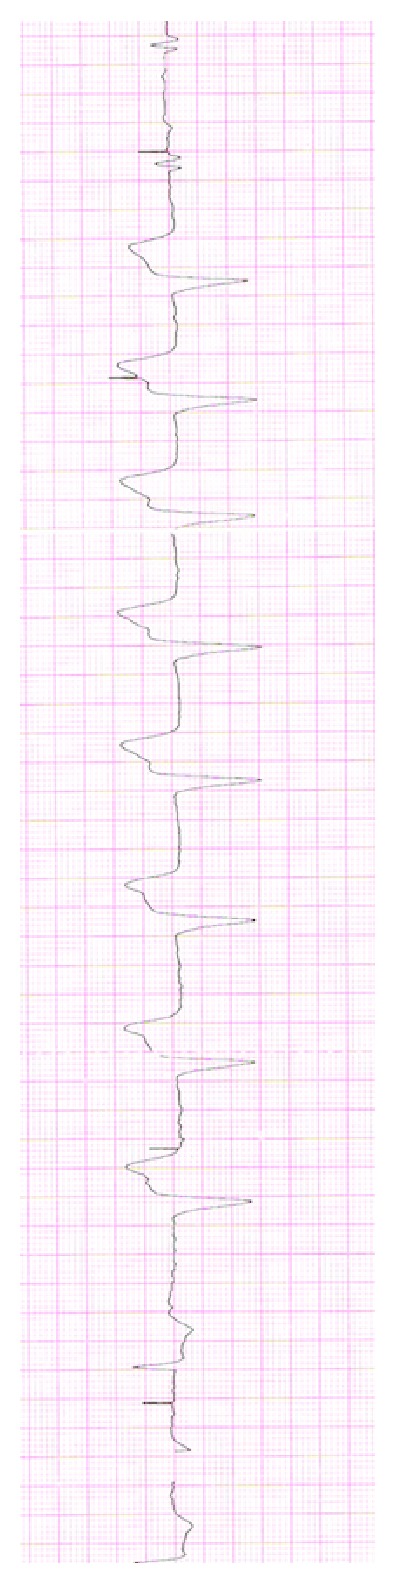
Electrocardiogram showing T wave inversion in the inferior and lateral leads.